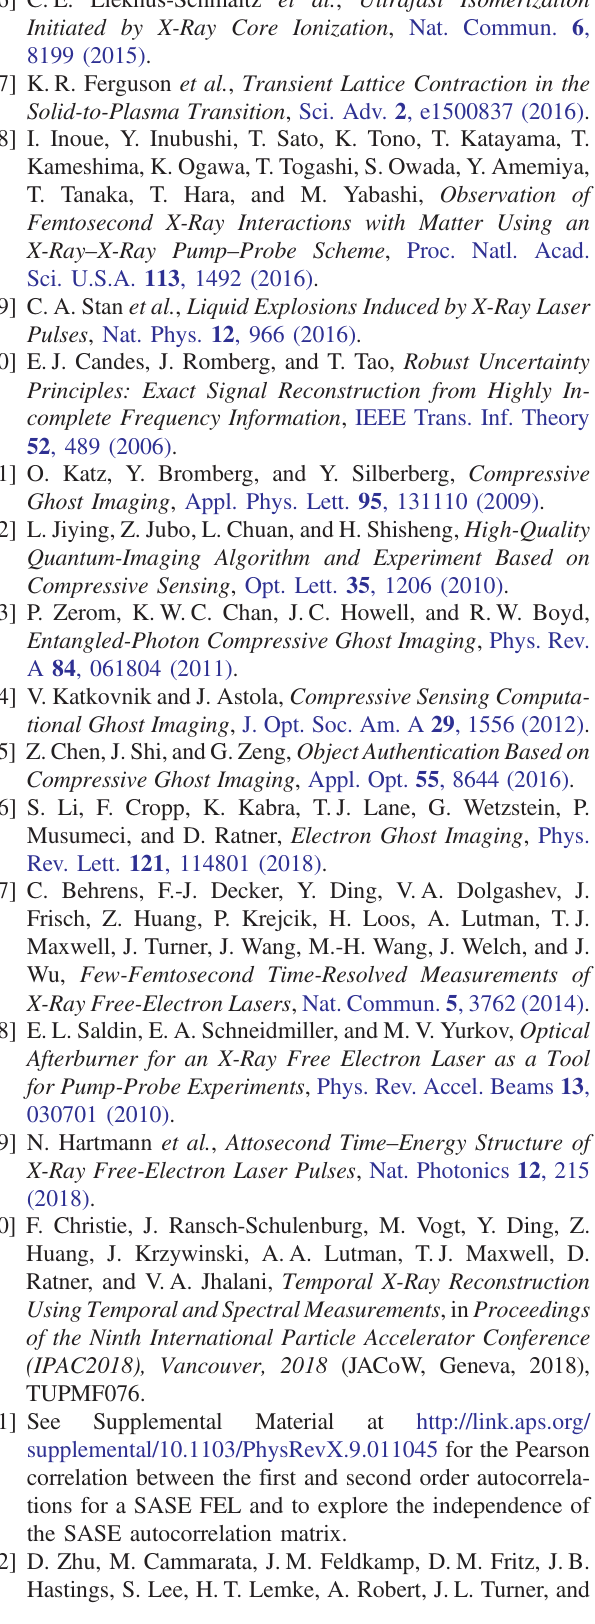
correlation between the first and second order autocorrela- tions for a SASE FEL and to explore the independence of the SASE autocorrelation